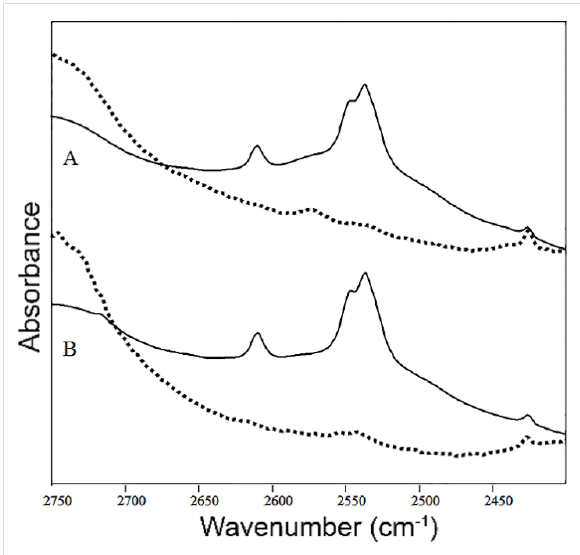
Figure 5: The infrared spectra of the ZrO 2 samples prepared in the presence of D 2 O and subsequently dried in vacuum at 25 °C (A) or at 800 °C (B). The dotted lines show the spectra after the samples were immersed for 60 min in H 2 O, following the drying process.